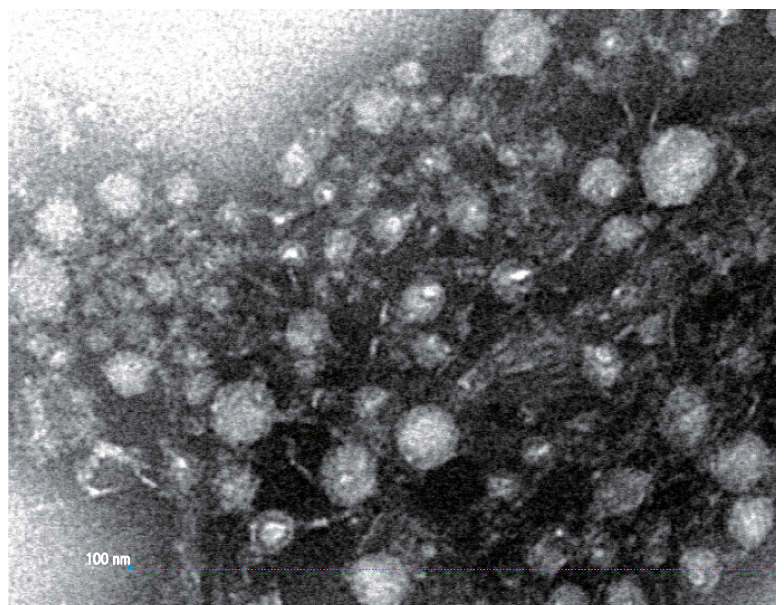
Figure 8. TEM section of pellet obtained by ultracentrifugation of Asobara japonica venom at 450,000 g. (Source: from [149] under the terms of Creative Commons Attribution Licence CC-BY 4.0 via PLoS ONE